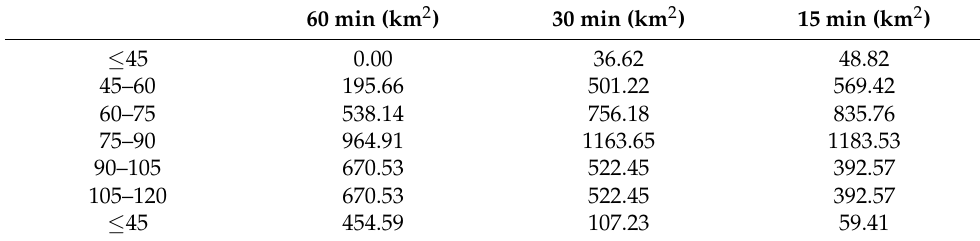
Figure 3. Spatial distribution pattern of accessibility. Note: The map is based on the standard map of the Map Technical Review Centre of the Ministry of Natural Resources of China (Number: GS (2019)4342), with no modifications to the base map; Map-making by author. Table 4. Comparison of accessible areas.